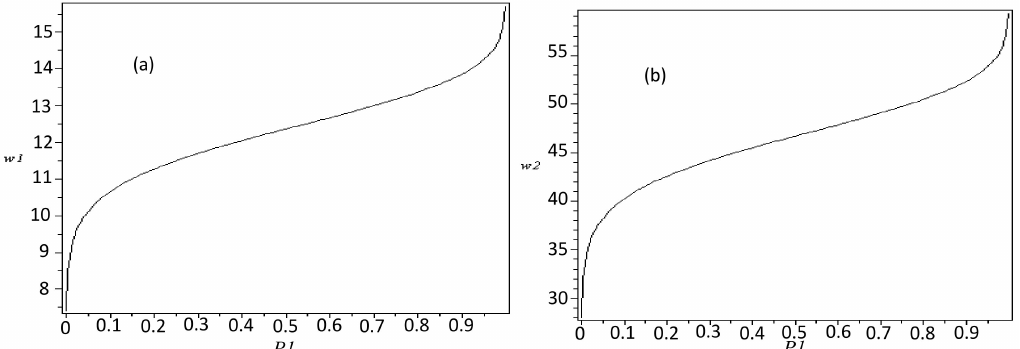
Figure 12. Circular natural frequency as a function of the probability P 1 (k 1 ) ( a ) Evolution of the first ( b ) Evolution of the second. Case 2: The stiffness k 1 is possibilistic